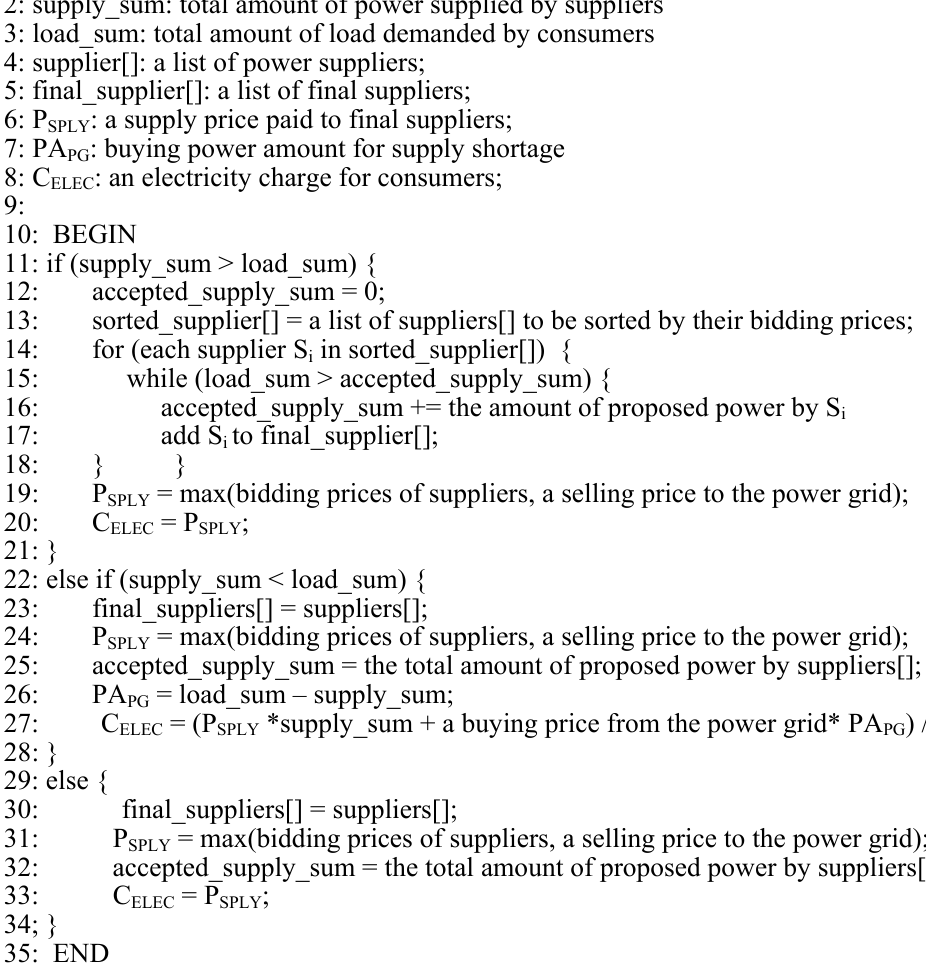
Figure 4. Pseudo codes for Ag